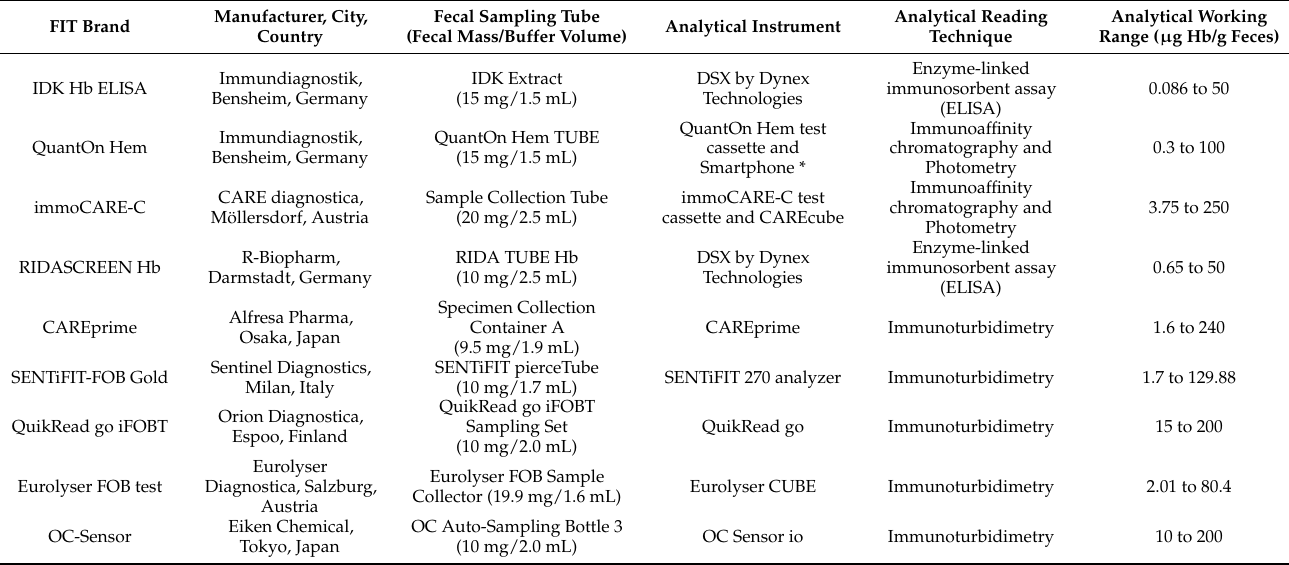
Table 1. Characteristics of the nine fecal immunochemical tests (FITs) (sorted by specificity value at original cutoffs). FIT